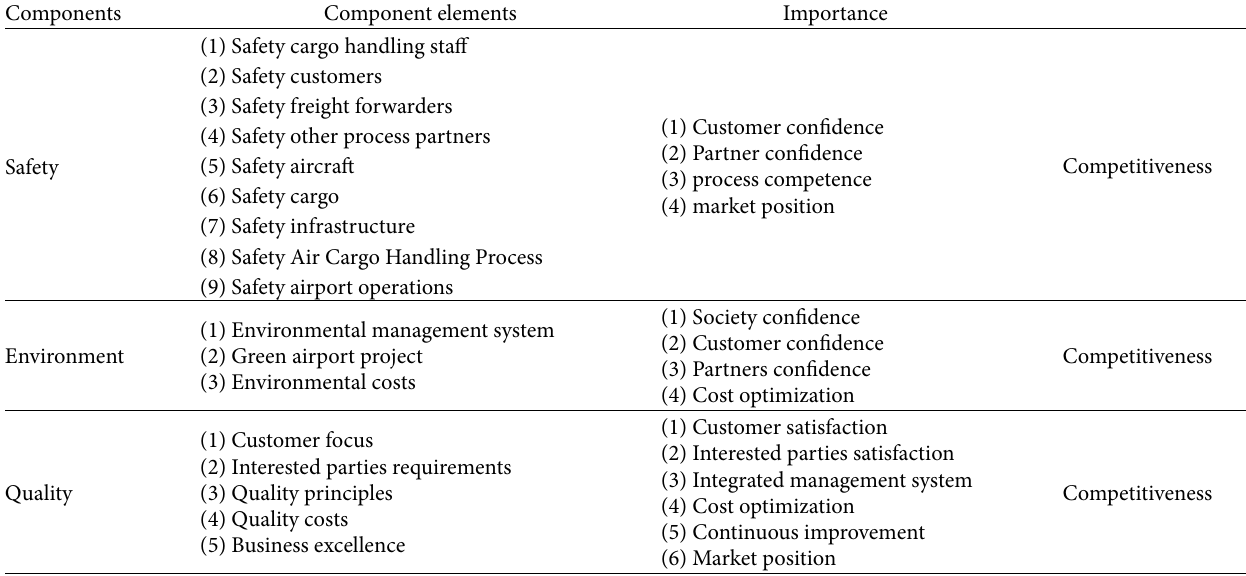
Table 2: The importance of Air Cargo Handling Process sustainability